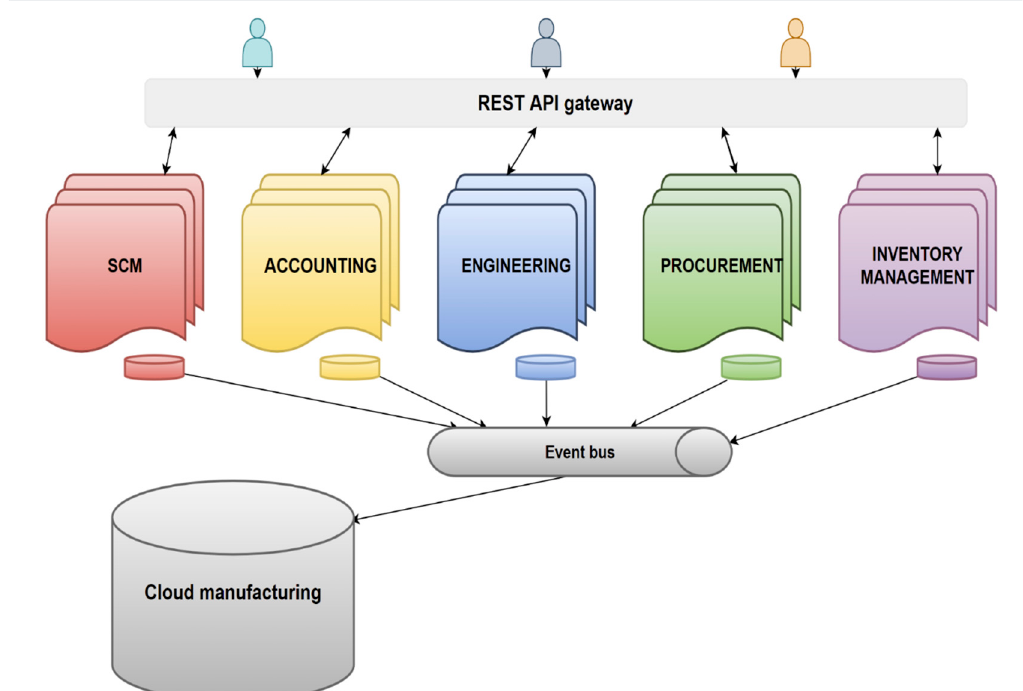
Figure 5. BCMaaS and SCM system architecture for boxed sheet metal manufacturing.